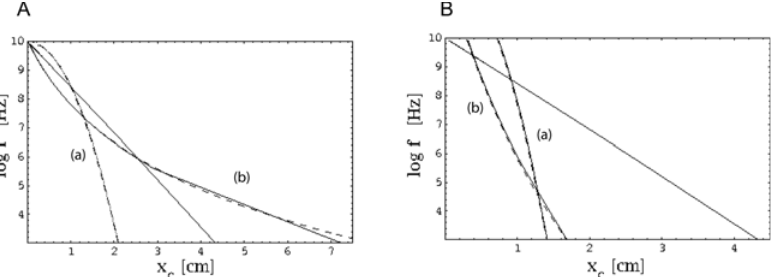
Figure 4. (a) E 0 x ð Þ ~ E 0 e { a x . Analytical prediction (dashed) and corresponding numerical evaluation (solid). From left bottom to right top: 0 E 0 0 [ 10 { 2 ,10 { 1 ,1,10,10 2 (cid:9) (cid:10) . (b) E 9 ( x )= E 0 e 2 a 9 x . Analytical prediction (dashed) together with the corresponding numerical evaluation (solid). From right E 0 top to left bottom: a